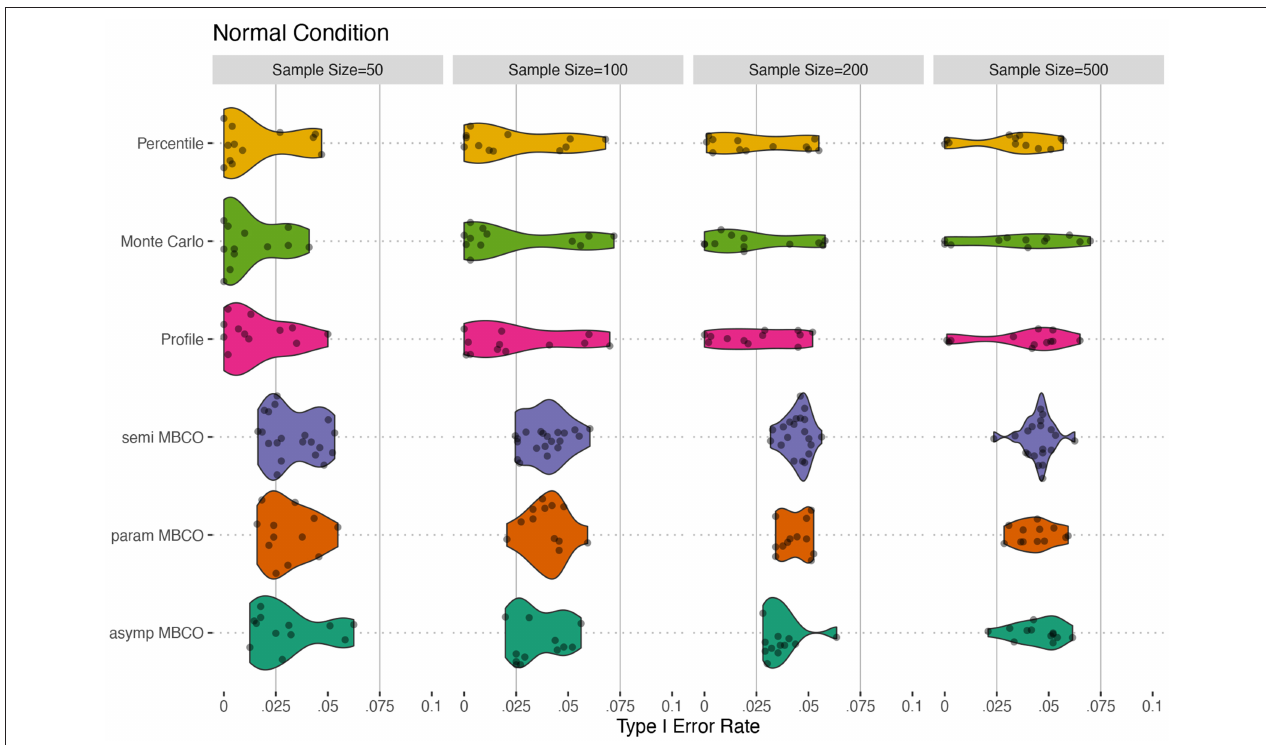
FIGURE 2 | Type I error for normal conditions for testing an indirect effect, β 1 β 2 β 3 , in a two-mediator sequential chain. Horizontal solid lines show the limits of Bradley (1978)’s interval of 0.025 and 0.075 for α = 0.05. asymp MBCO, asymptotic MBCO LRT; param MBCO, parametric bootstrap MBCO LRT; semi MBCO, semi-parametric bootstrap MBCO LRT; Profile, Profile-Likelihood CI; Monte Carlo, Monte Carlo CI; Percentile, Percentile non-parametric